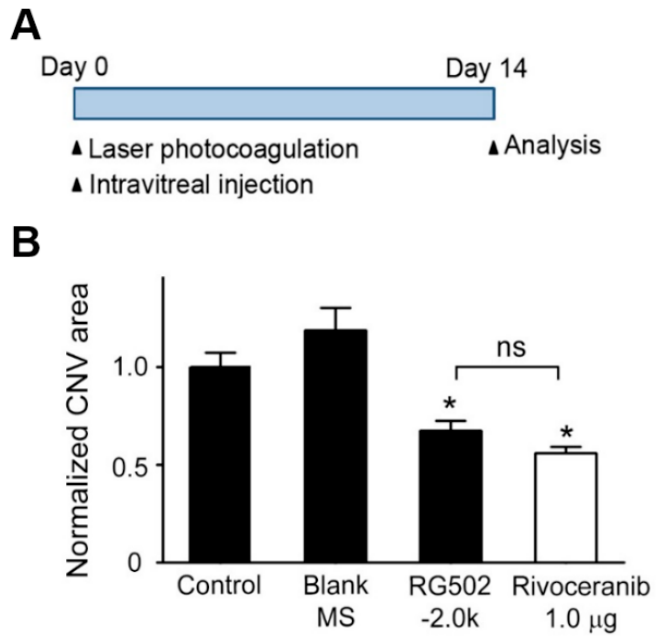
Figure 6. Inhibitory effect of rivoceranib-loaded PLGA microspheres and rivoceranib on laser- induced CNV formation in mice. ( A ) In vivo treatment schedule for the laser-induced choroidal neovascularization (CNV) experiment. ( B ) Immediately after laser photocoagulation, the mice received a single intravitreal injection of PBS (1 µ L; n = 10 mice, Control), drug free RG502H microspheres (10% microsphere in 1 µ L PBS, n = 4 mice, Blank MS), and rivoceranib-loaded PLGA 502H microspheres (10 µ g rivoceranib/10% 502H − 2.0k in 1 µ L PBS, n = 10 mice). Two weeks later, the CNV area was analyzed. Rivoceranib (1.0 µ g rivoceranib in 1 µ L DMSO, n = 4 mice) and PBS (1 µ L; n = 10 mice, Control). Two weeks later, the CNV area was analyzed. The CNV area was quantified by measuring the fluorescence intensity of images with isolectin IB4-positive areas. CNV areas of samples were expressed relative to that of control (one-way ANOVA with Bonferroni post hoc multiple comparison test, ns = not significant, * p < 0.05 vs. blank MS). Data are presented as the mean ±